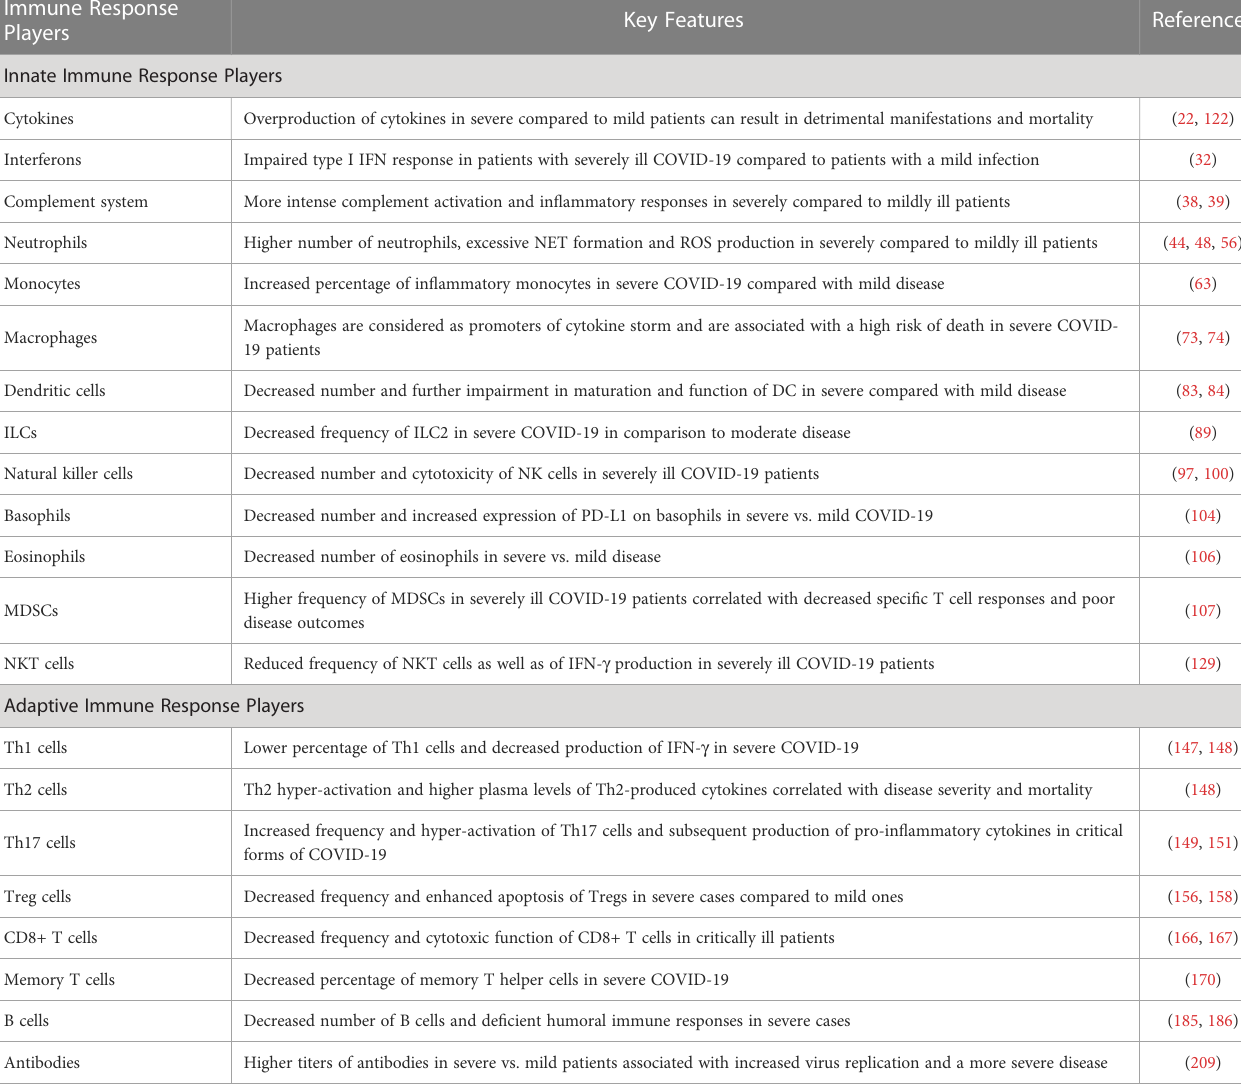
TABLE 2 Key features of immune responses in mildly versus critically ill COVID-19 patients. Immune Response